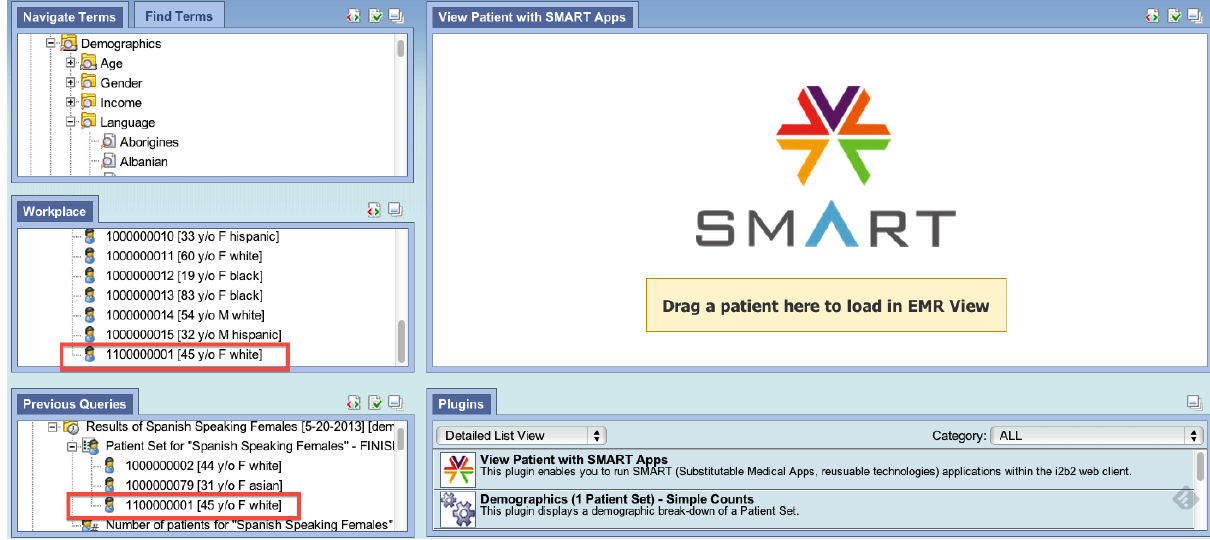
Figure 5. The i2b2 Web application with the SMART container activated. A patient can be dragged from a patient list in the workplace (first oval) or from a previous query result (second oval).